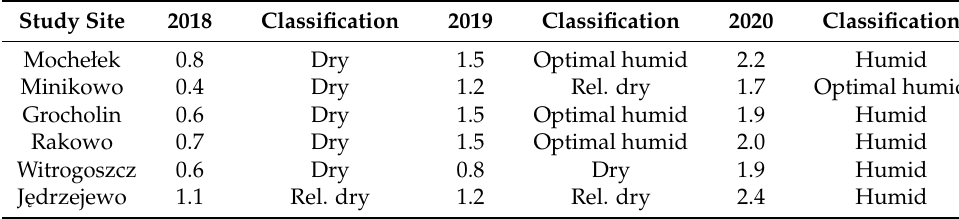
Table 5. Hydrothermal coefficient ( K ) calculated for the seasons 2018–2020 for the study sites. Study